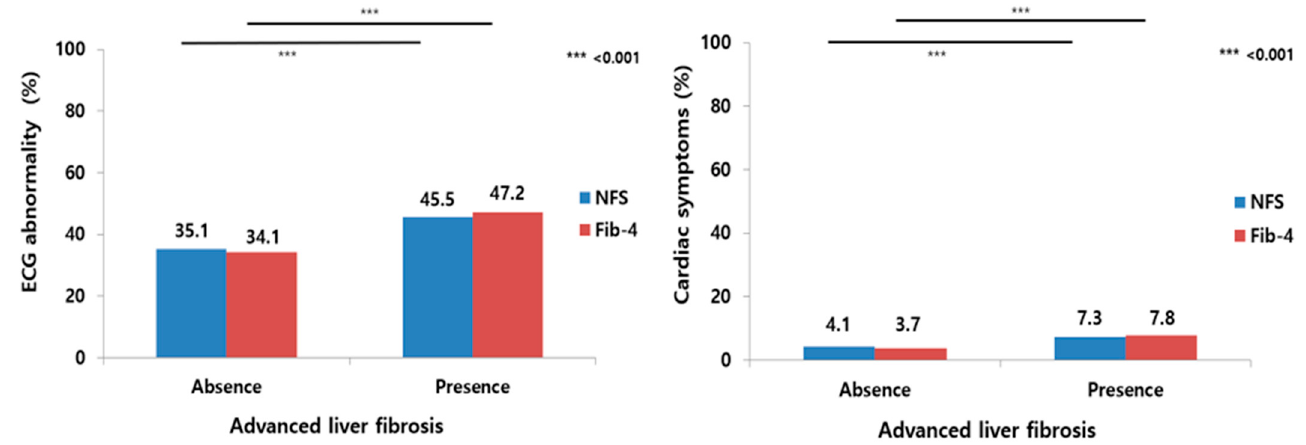
Figure 2. The percentage differences of ECG abnormalities ( left ) and cardiac symptoms ( right ), according to the presence or absence of advanced liver fibrosis using two fibrosis scoring systems in patients with nonalcoholic fatty liver disease. ECG, electrocardiogram; NFS, nonalcoholic fatty liver disease fibrosis score; Fib-4, fibrosis-4 index.